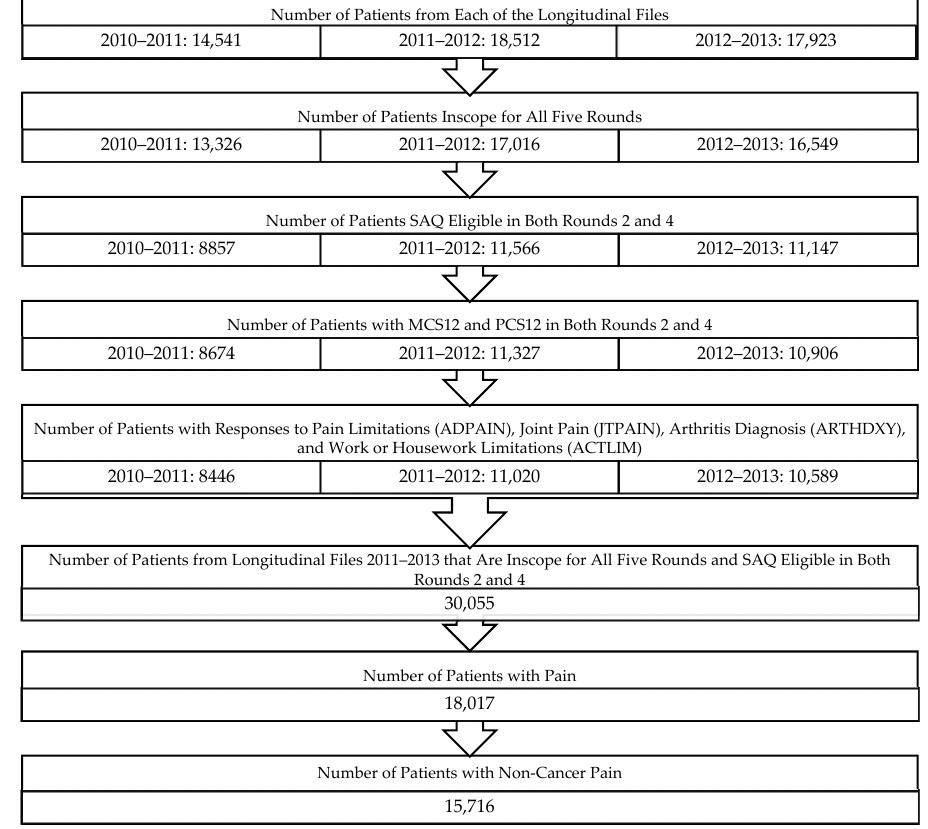
Figure 1. Derivation of study sample.